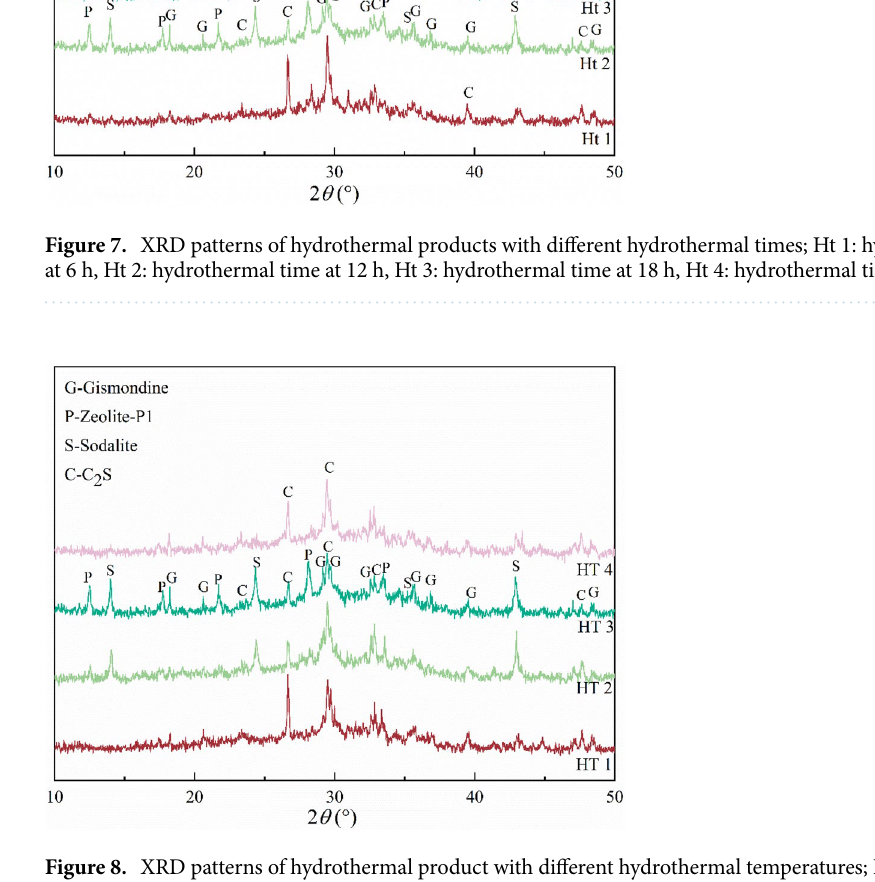
Figure 8. XRD patterns of hydrothermal product with different hydrothermal temperatures; HT 1: hydrothermal temperature at 60 °C, HT 2: hydrothermal temperature at 90 °C, HT 3: hydrothermal temperature at 120 °C, HT 4: hydrothermal temperature at 150